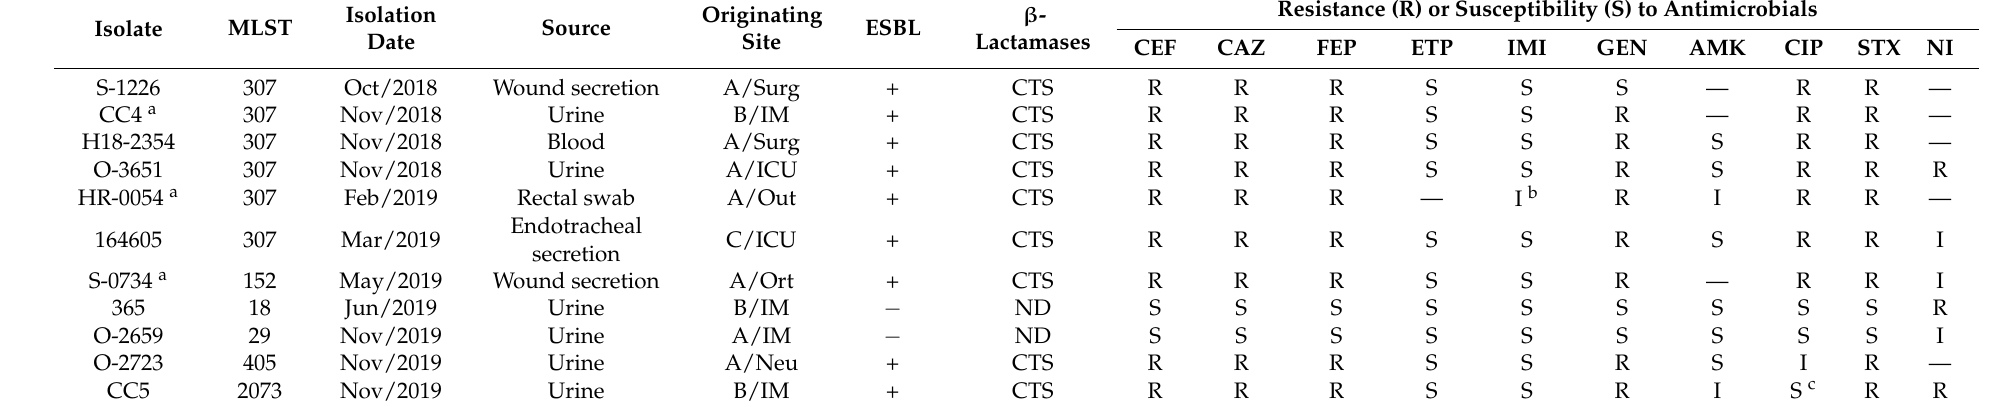
Table 2. Phenotypic and genotypic characteristics of Klebsiella pneumoniae